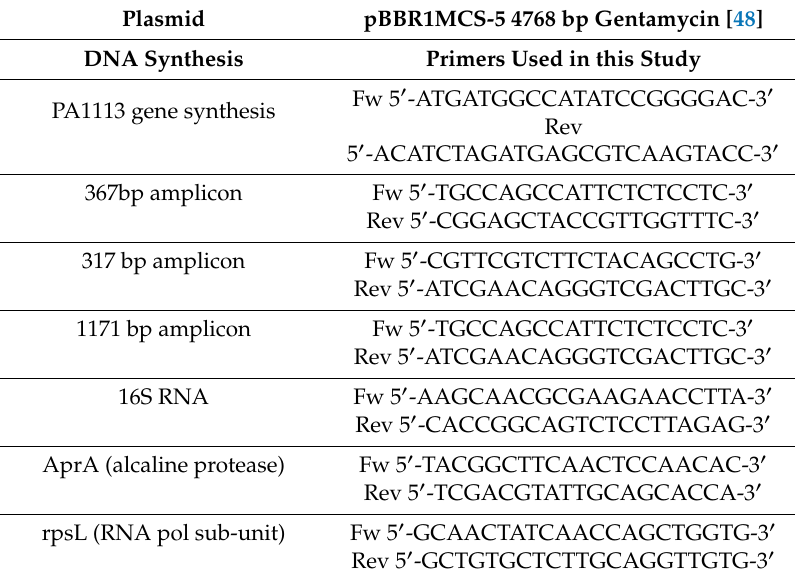
Table 4. Plasmid and primers used for PCR